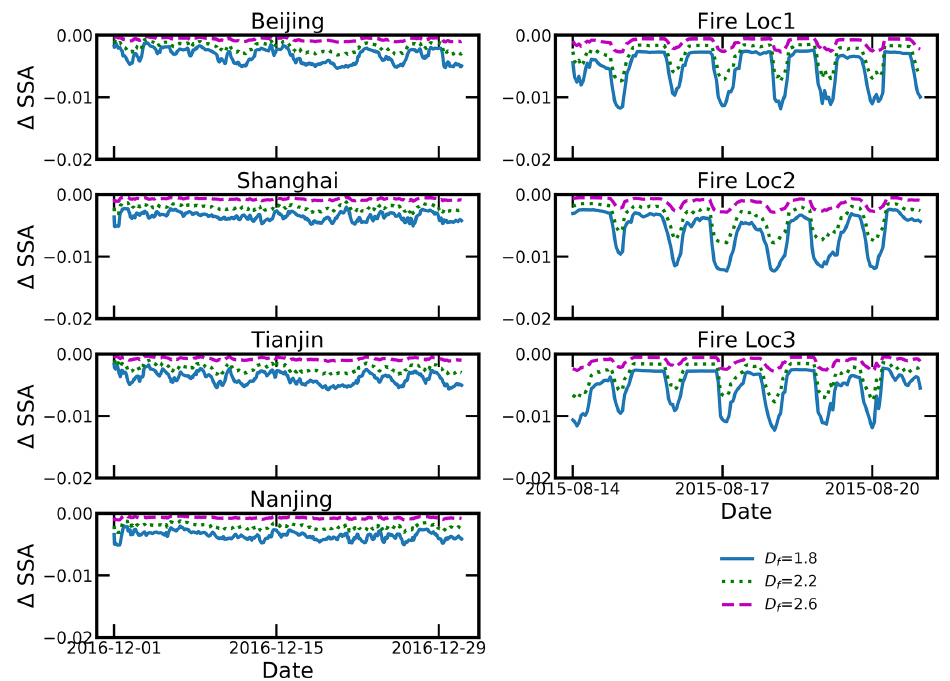
Figure 11. The SSA differences between fractal aggregate models and the spherical model, λ = 450nm.